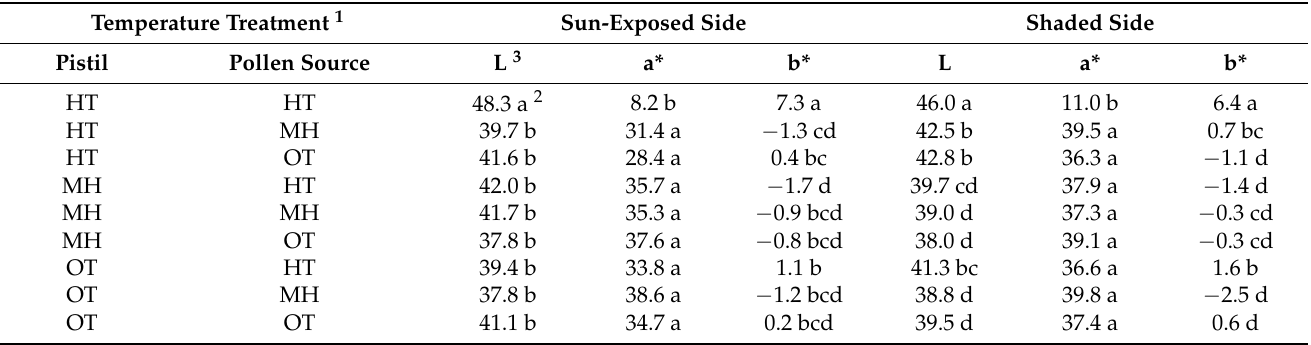
Table 4. Comparison of peel color from self-pollination or mutual cross combinations by HT, MH, and OT treatments in “Da Hong” pitaya at harvest in